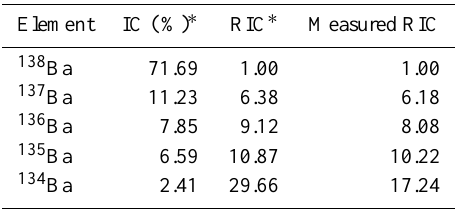
Table 1. Isotopic composition (IC) and relative isotopic composi- tion (RIC) according to NIST database and measured with the SP- AMS.